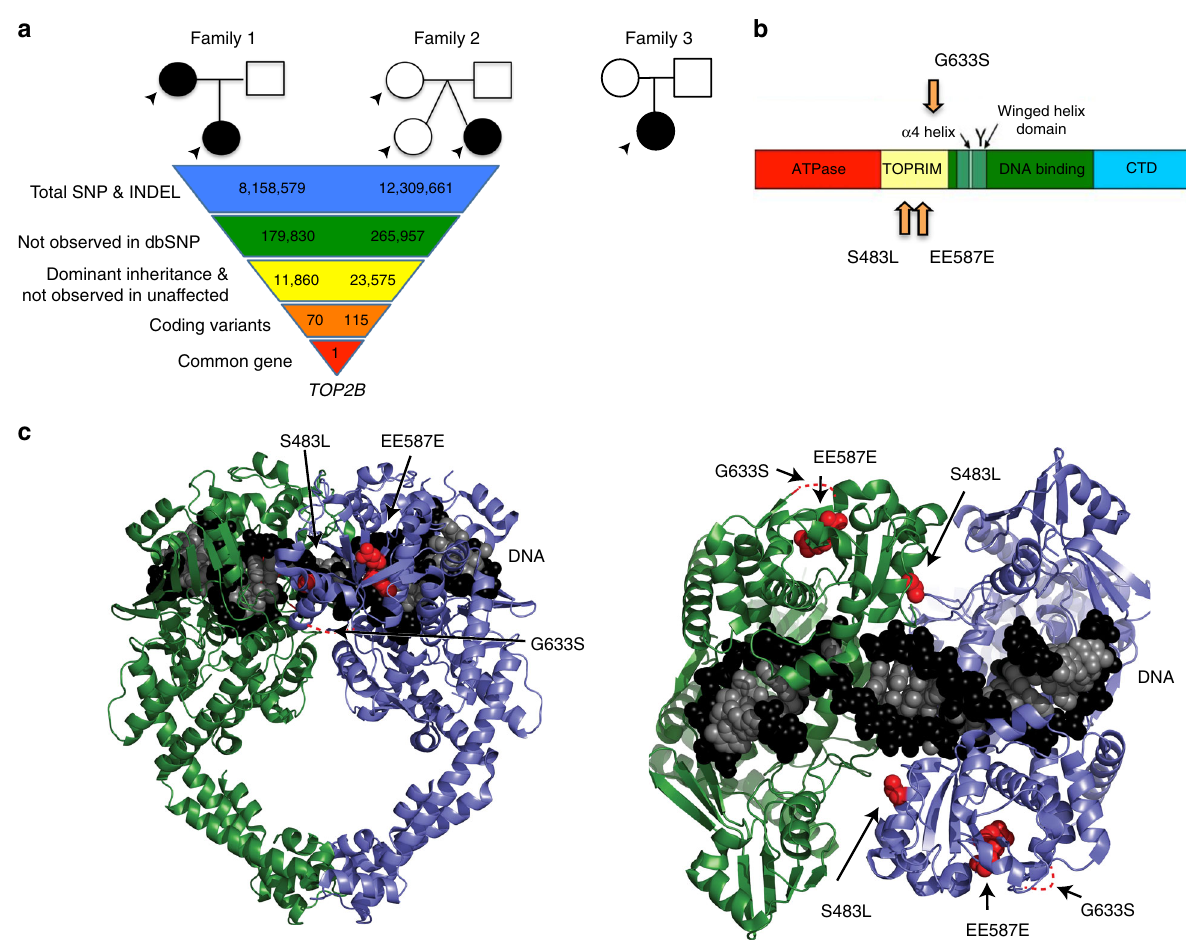
Fig. 1 Mutations in TOB2B cause peripheral B-cell immunode fi ciency and dysmorphic features. a Pedigrees in three unrelated families with variants in TOP2B . Filled symbols, subjects with mutation; open symbols, unaffected subjects. Arrows indicate individuals subjected to whole genome sequencing. Three variants were identi fi ed: a missense mutation c.1448C > T, p.S483L, a de novo inframe deletion c.1761_1763AGAdel p.EE587E, a missense